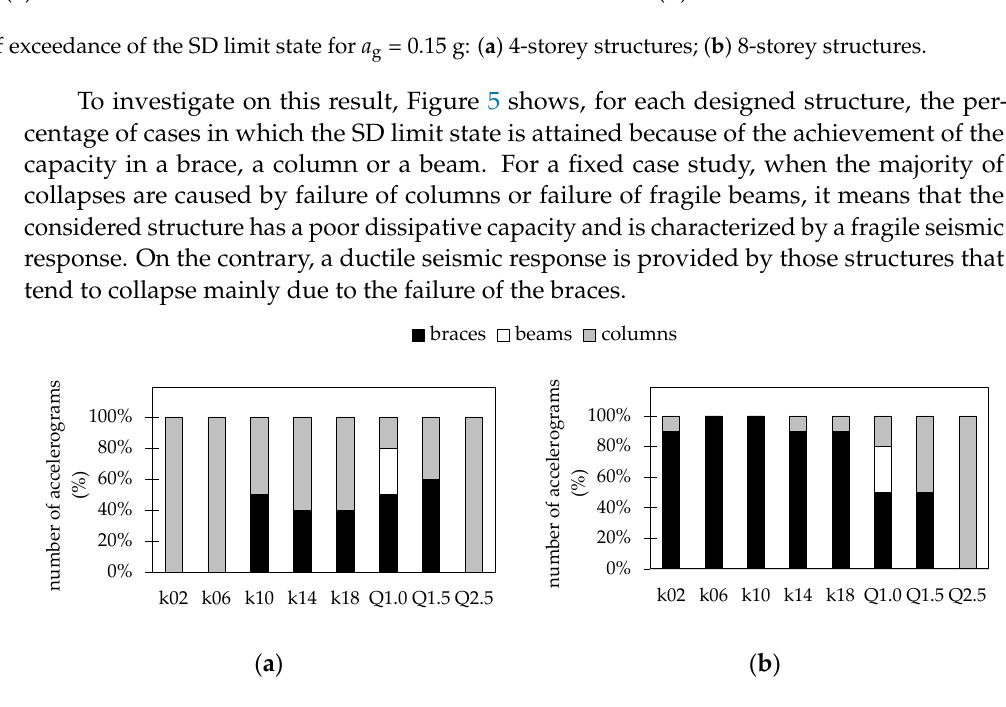
Figure 5. Percentage number of accelerograms leading to DI = 0.75 in braces or RI = 1, SI = 1, TI = 1 in beams and columns: ( a ) 4-storey structures; ( b ) 8-storey structures.